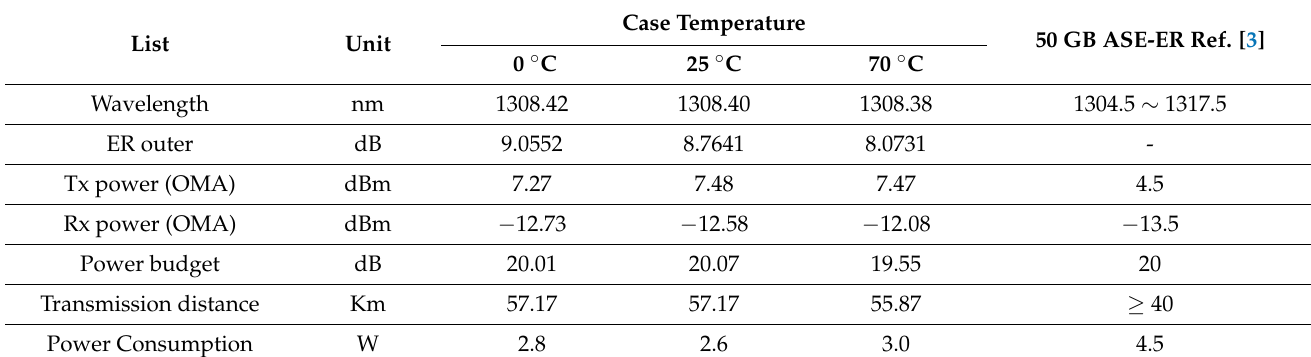
Table 4. Measurements of the QSFP28 PAM4 optical transceiver parameters.